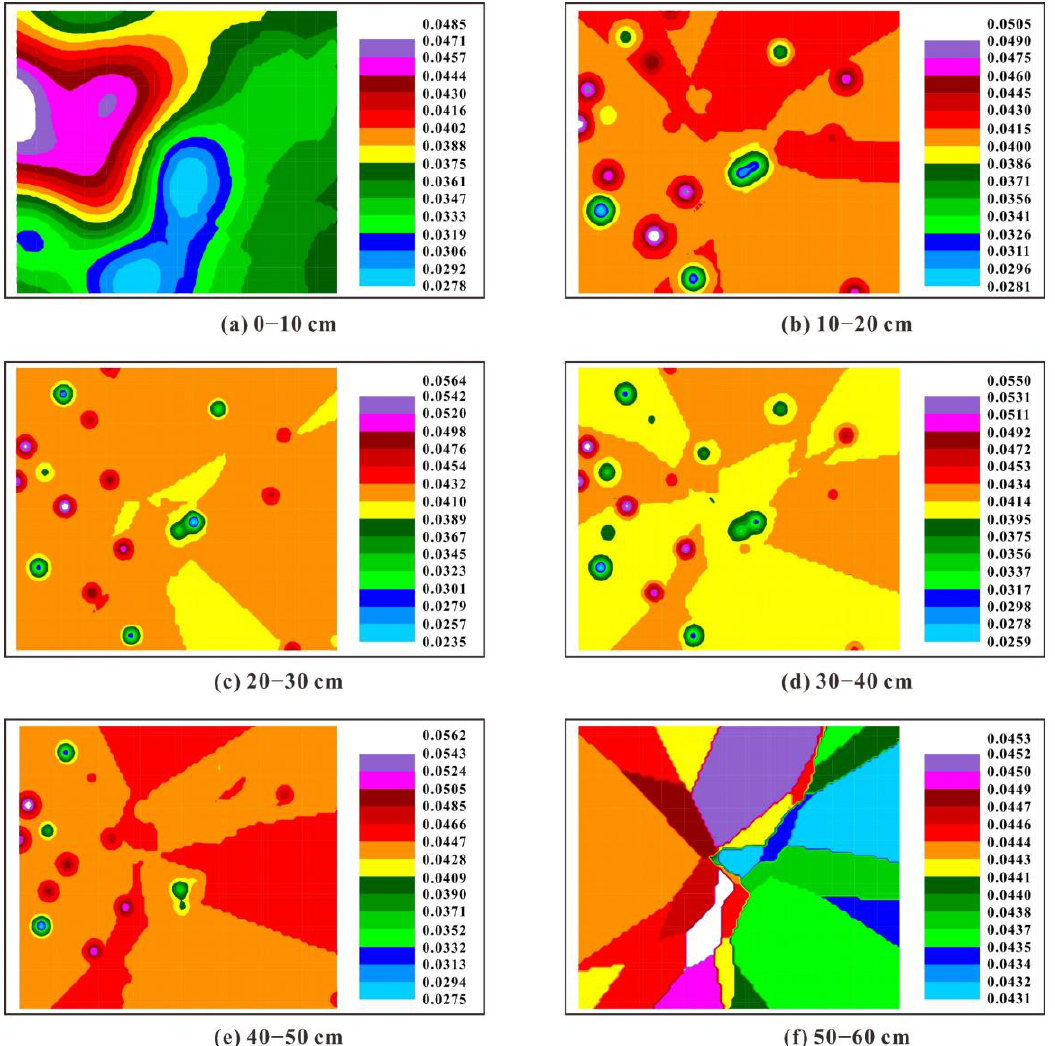
Figure 3. Spatial distribution maps of the K factor (t ha h (ha MJ mm) −1 ) in the South Dump based on the ordinary kriging interpolation. ( a – f ) represent the soil layers at different depths (0–10 cm, 10–20 cm, 20–30 cm, 30–40 cm, 40–50 cm and 50–60 cm).